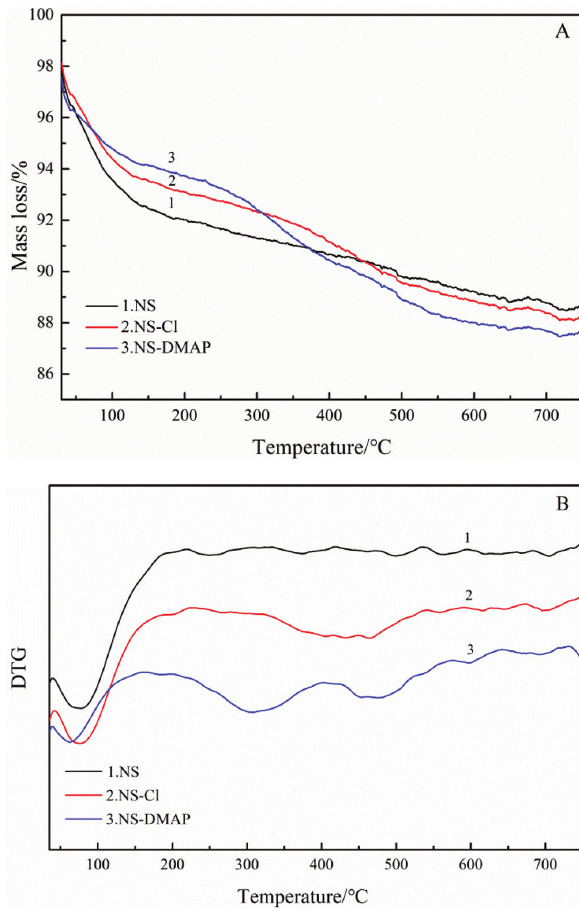
Figure 3: TG, DTG curves of (1) NS, (2) NS-Cl, (3) NS-DMAP.